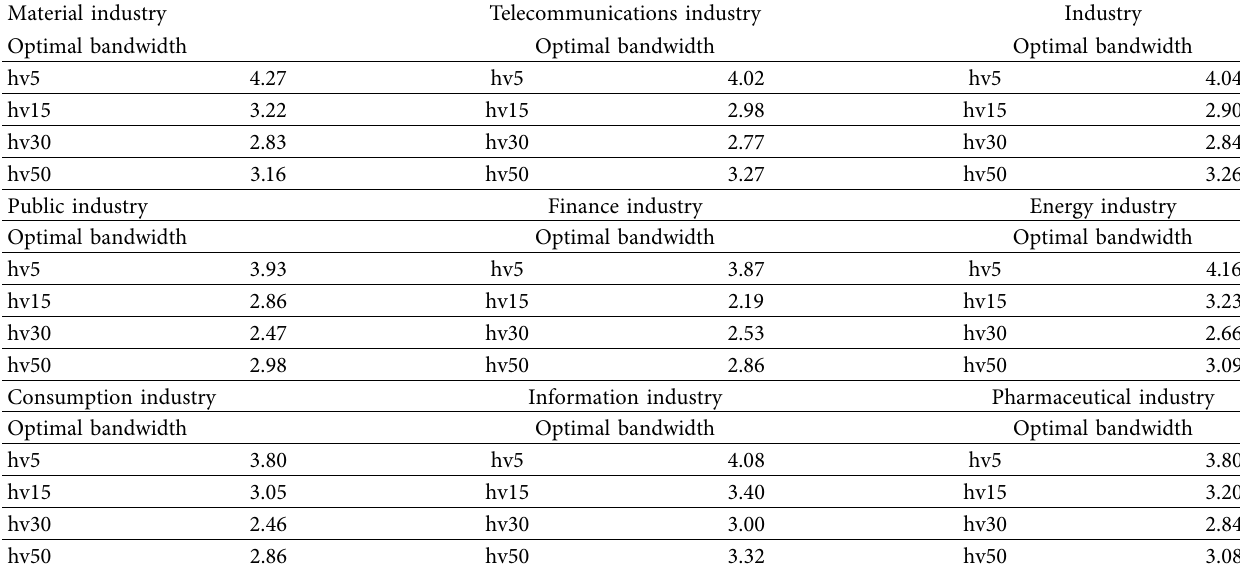
Table 2: The optimal bandwidth for all observations.